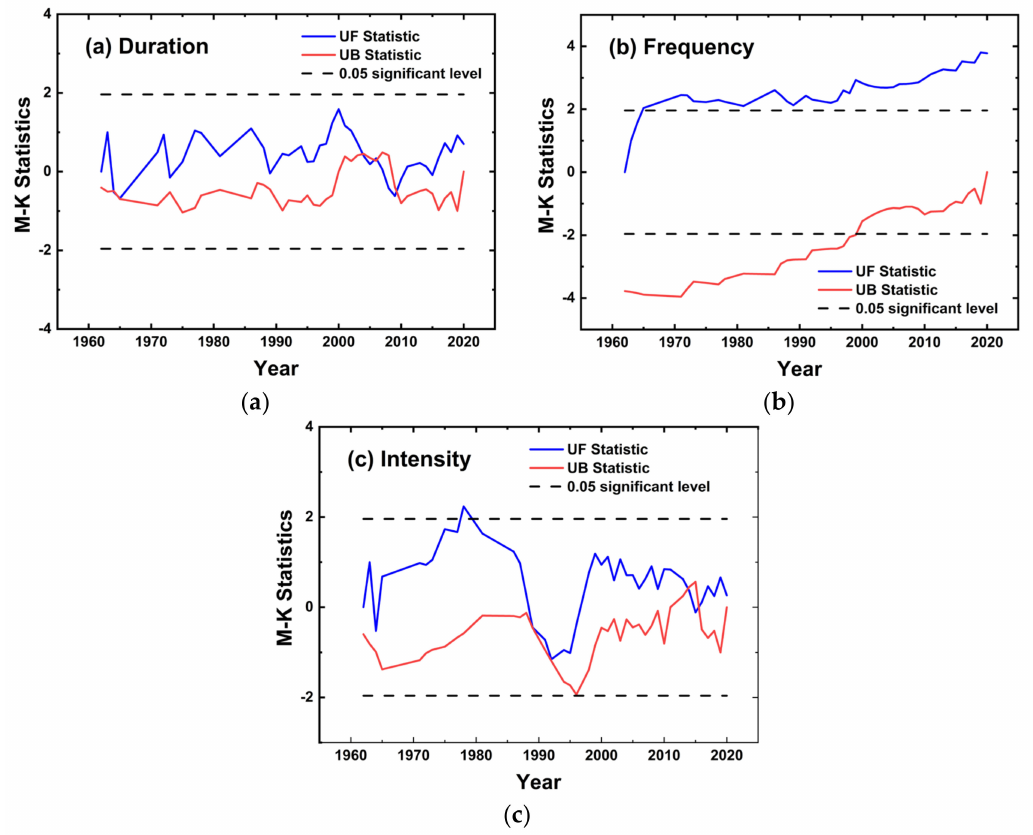
Figure 4. Mutation analysis of duration ( a ), frequency ( b ) and intensity ( c ) of heatwaves in Hexi Oasis (UF and UB are the critical values corresponding to ± 1.96 at the 0.05 significance level